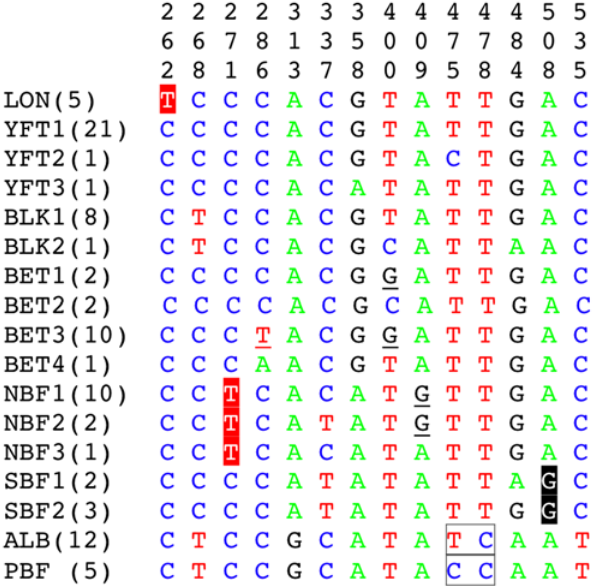
Figure 1. Character-based key for all species of tunas ( Thunnus ) derived from 87 reference sequences [ 49,53 ] constituting 14 nucleotides. Numbers in brackets indicate the number of individual sequences. Nucleotide positions are numbered following Ward et al.’s [49] sequences. Simple pure characteristic attributes (CAs; highlighted) identify longtail ( T. tonggol ; LON), northern bluefin ( T. thynnus ; NBF), and southern bluefin ( T. maccoyii ; SBF) tuna. Simple private CAs (underlined) diagnose bigeye tuna ( T. obesus ; BET). Compound pure CAs diagnose yellowfin tuna ( T. albacares ; YFT), blackfin tuna ( T. atlanticus ; BLK), albacore( T.alalunga ; ALB), andPacific bluefintuna( T.orientalis ; PBF). Though albacore mtDNA has introgressed into the Pacific bluefin tuna mitogenome, compound pure CAs can differentiate these species (boxed). match, the BOLD all species search yielded a 100% match for four species: bigeye tuna, blackfin tuna, yellowfin tuna, and dogtooth tuna ( Gymnosarda unicolor ), thus yielding ambiguous identifications for 10% of the samples searched. The BOLD reference database matched BLAST and BOLD all species searches for the three bluefin species and albacore. The BOLD reference database failed to return an identification for escolar, and yielded a top match for all samples identified in the other databases as bigeye tuna or yellowfin tuna as blackfin tuna. As a result, the BOLD reference database failed to identify 62% of the samples.